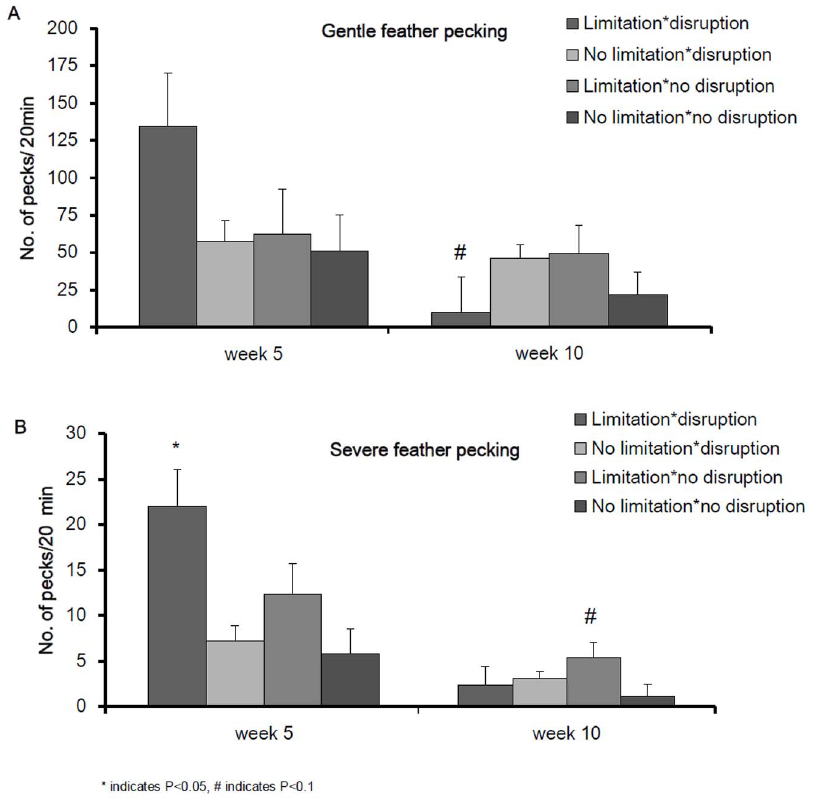
Figure 3. A. Gentle feather pecking at 5 and 10 weeks of age in relation to litter disruption and litter limitation B. Severe feather pecking at 5 and 10 weeks of age in relation to litter disruption and litter